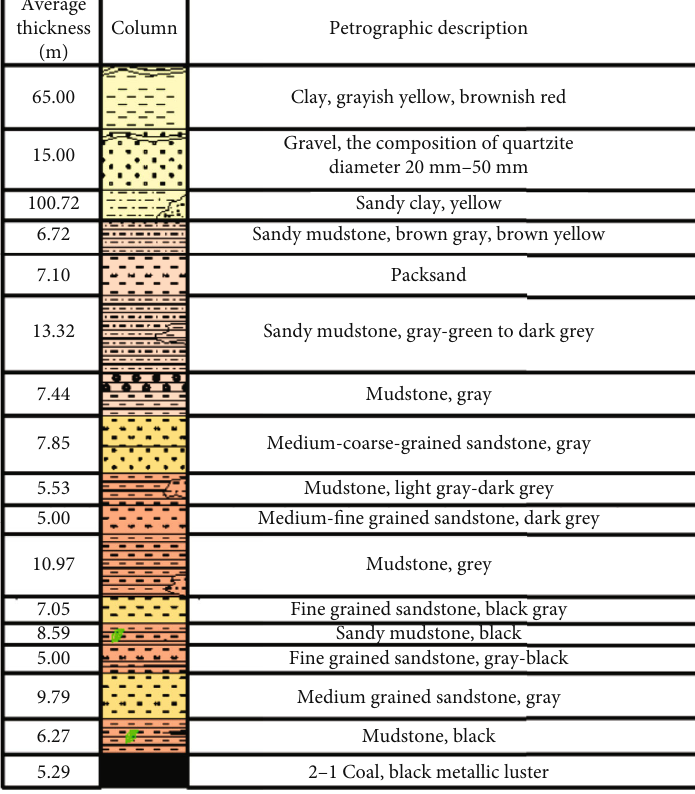
Figure 2: Comprehensive histogram of coal seam